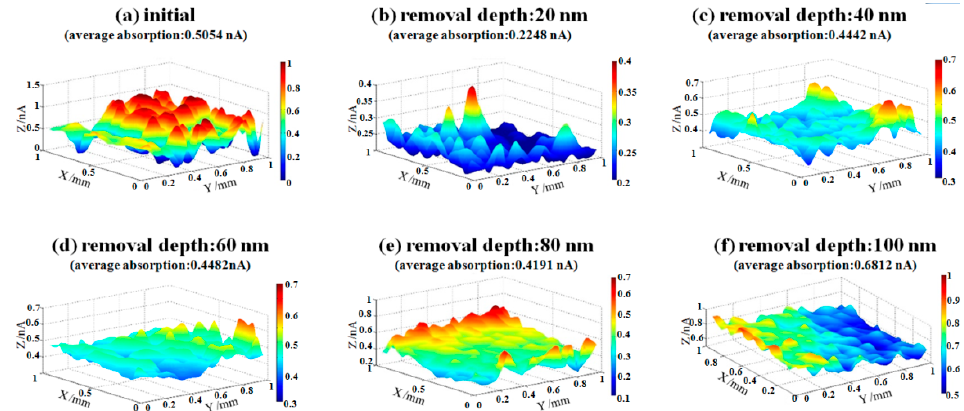
Figure 12. Weak absorption evolution of sample #1 in EJP processing.